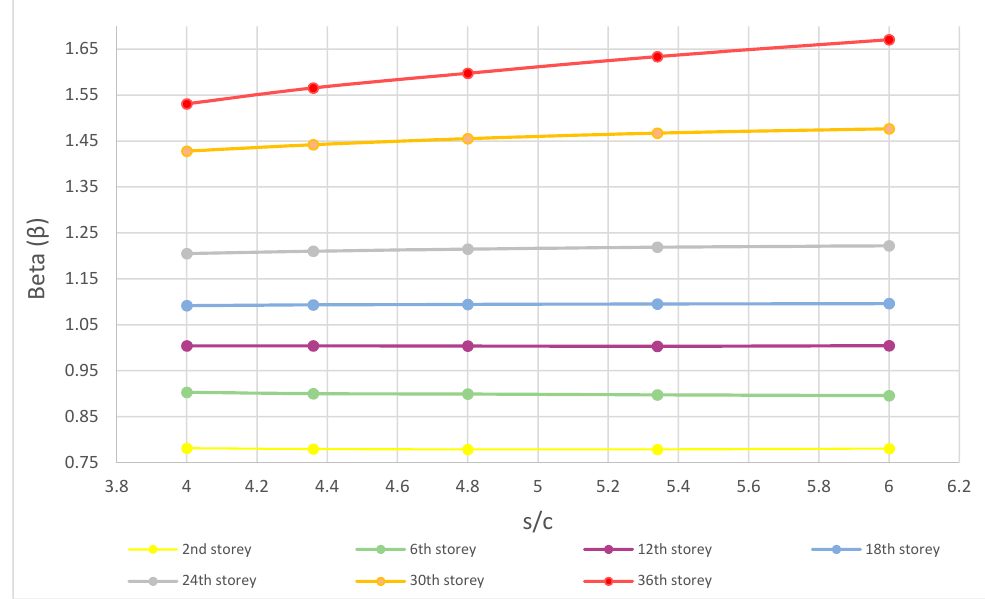
Figure 9. The change in the shear lag effect with the variation of column spacing ( β —s/c diagram). According to the results (Figure 9) the following can be